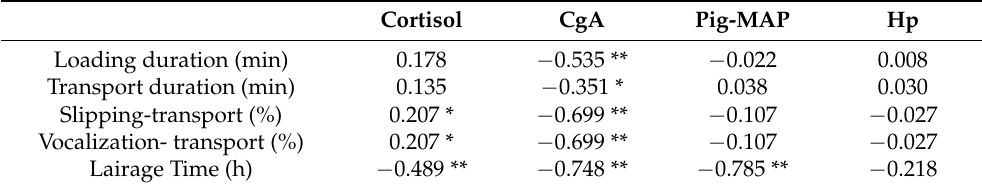
Table 3. Partial Spearman correlations (rs) between the stress biomarkers, acute-phase pro- teins concentrations (log 10 values) at bleeding point after different lairage times, transport and lairage